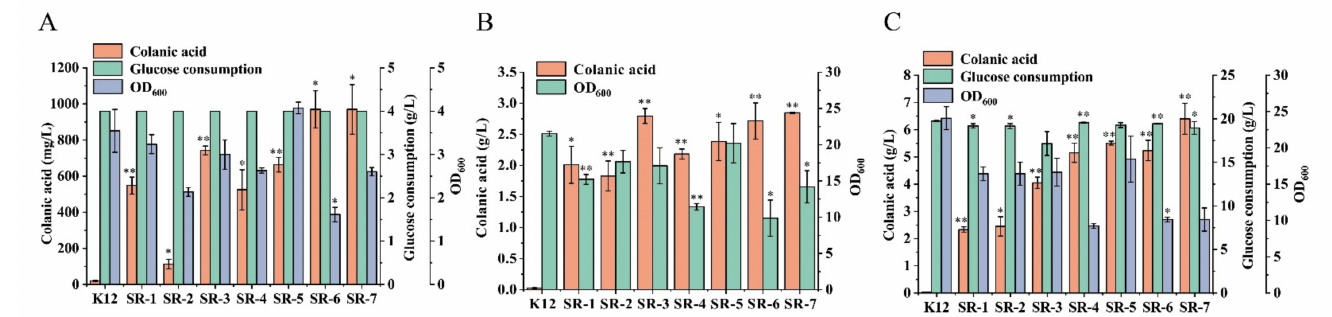
Figure 3. Relieving the regulation of the RCS phosphorylation system on the synthesis of colanic acid and the optimization of medium. ( A ) Colanic acid titers of SR recombinant strains in M9 medium at 30 ◦ C in shake flasks. ( B ) Colanic acid titers of SR recombinant strains in TB medium at 30 ◦ C in shake flasks. ( C ) Colanic acid titers of SR recombinant strains in TBG medium at 30 ◦ C in shake flasks. Statistical data analysis was performed with t-texts in SPSS 25.0. p values of <0.05 were considered statistically significant, and statistical significance is indicated as * for p < 0.05 and ** for p < 0.01. Table 1. Log2 ratio of wza gene expression in SR-series strains to that in the E. coli K-12.